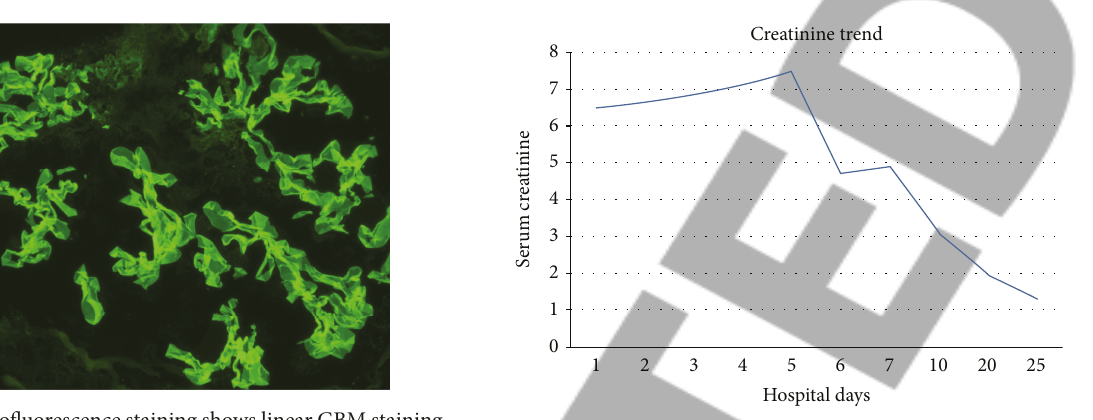
Figure 3: Graph showing trend of creatinine (mg/dL) while in the hospital. Plasmapheresis and corticosteroids were initiated on day 3. Hemodialysis was initiated on day 5. Daily plasmapheresis with high dose prednisone at 60 mg/day was continued until discharge. Hemodialysis was done intermittently three times a